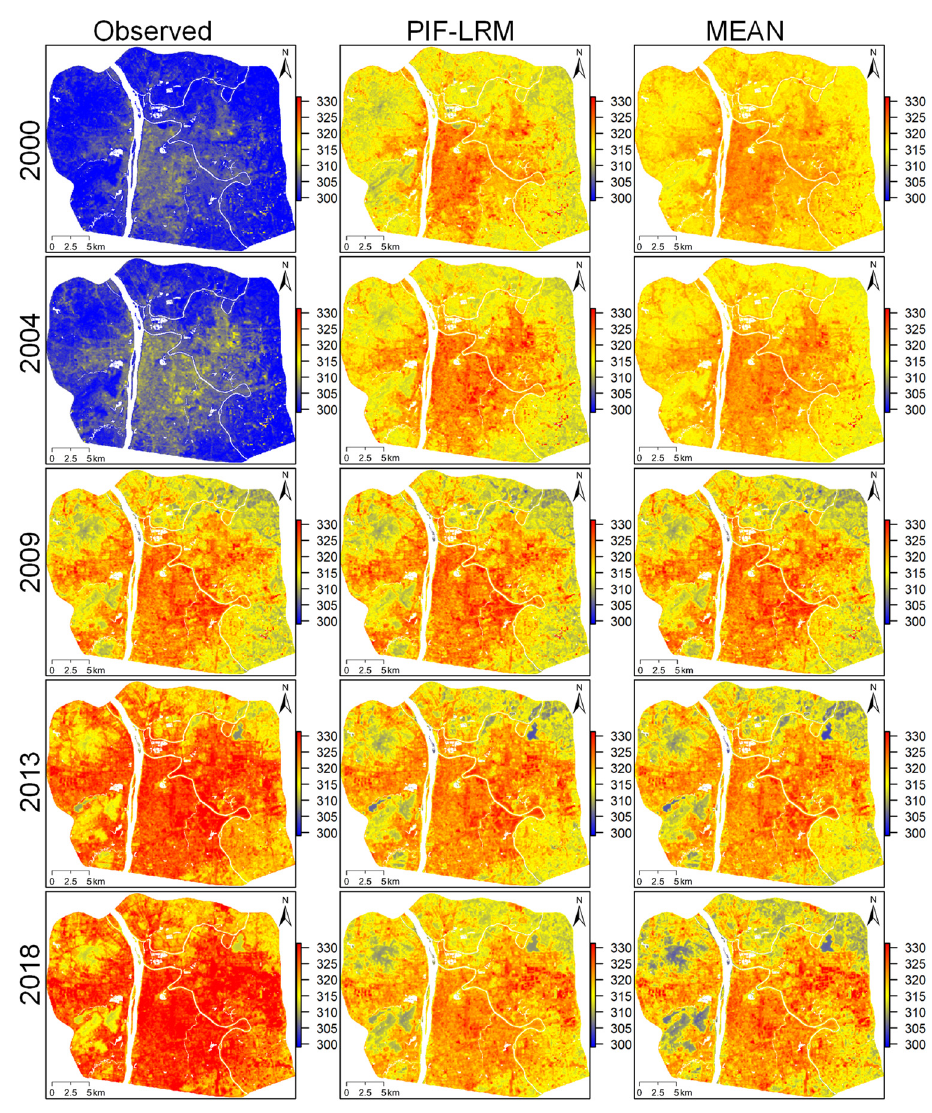
Figure 8. Observed Landsat LST (left column), PIF-LRM normalized LST (middle column), and MEAN normalized LST (right column).